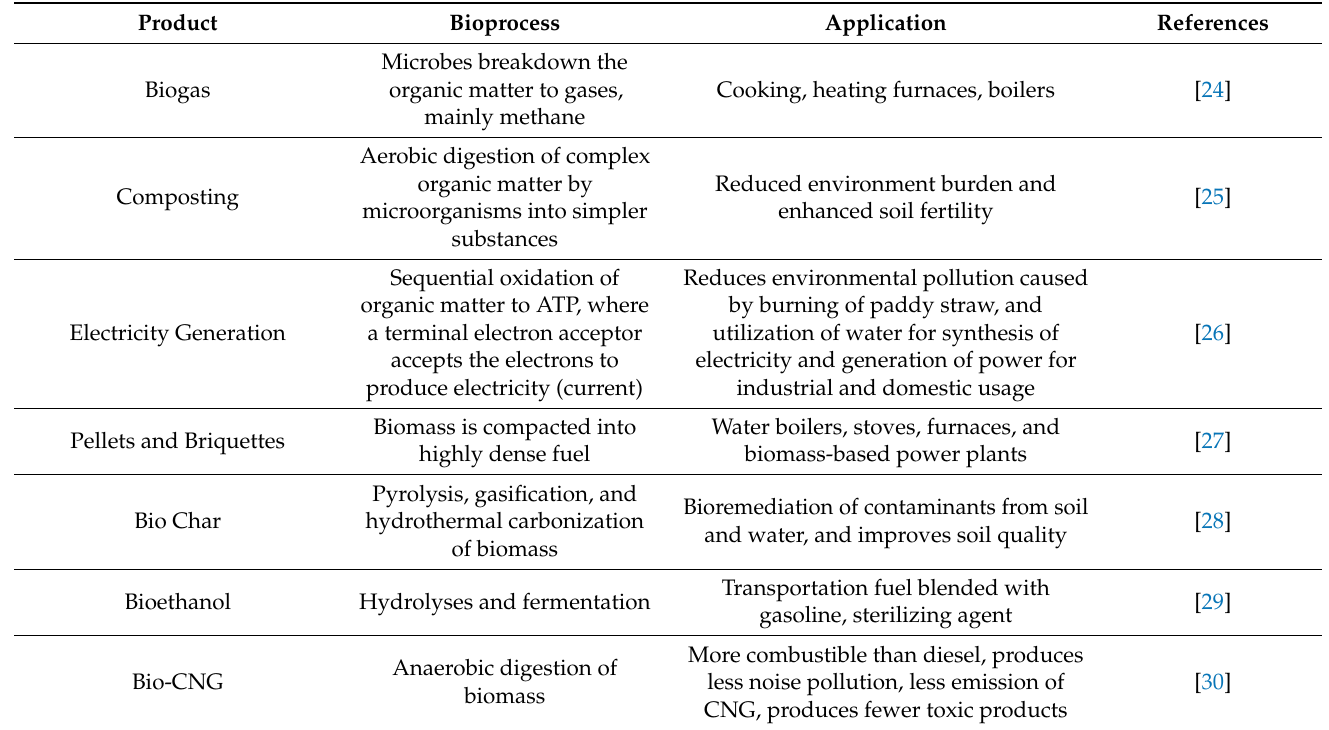
Table 1. Important biorefinery products produced using rice straw biomass and their